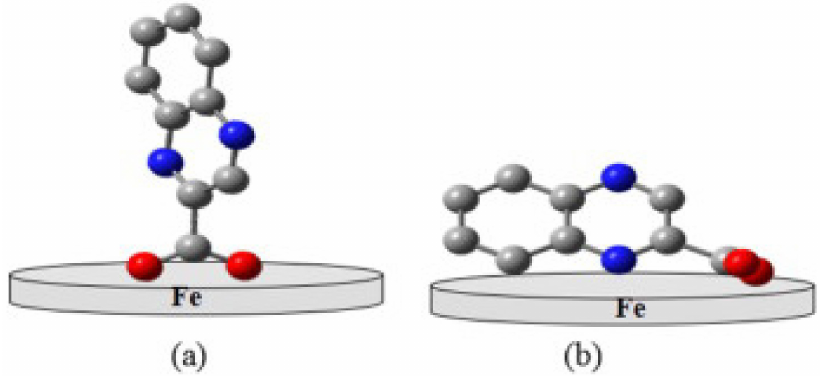
Figure 4. Adsorption configuration of sodium 2-quinoxalinecarboxylate on iron substrate; ( a ) vertical and ( b ) horizontal orientation, reproduced from [96], with permission from Elsevier,